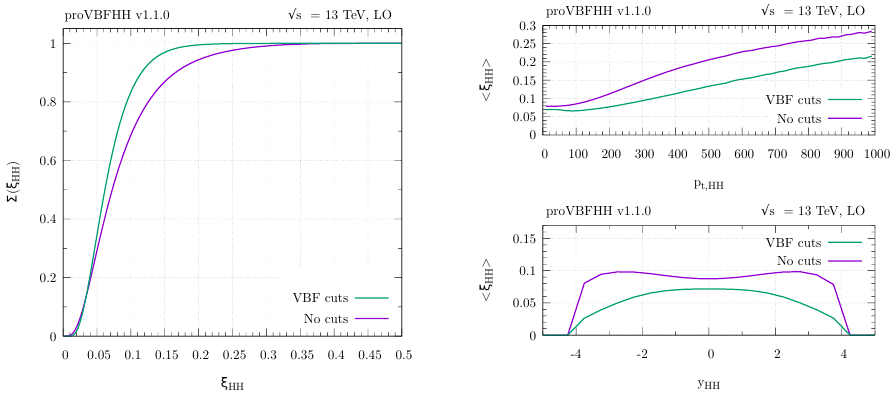
Figure 13. Left: the normalised integrated cross section as a function of (cid:24) fully inclusively (purple) and under the VBF cuts of section 3.1 (green) for di-Higgs production through VBF. Right: the average of (cid:24) HH as a function of y HH and p t;HH